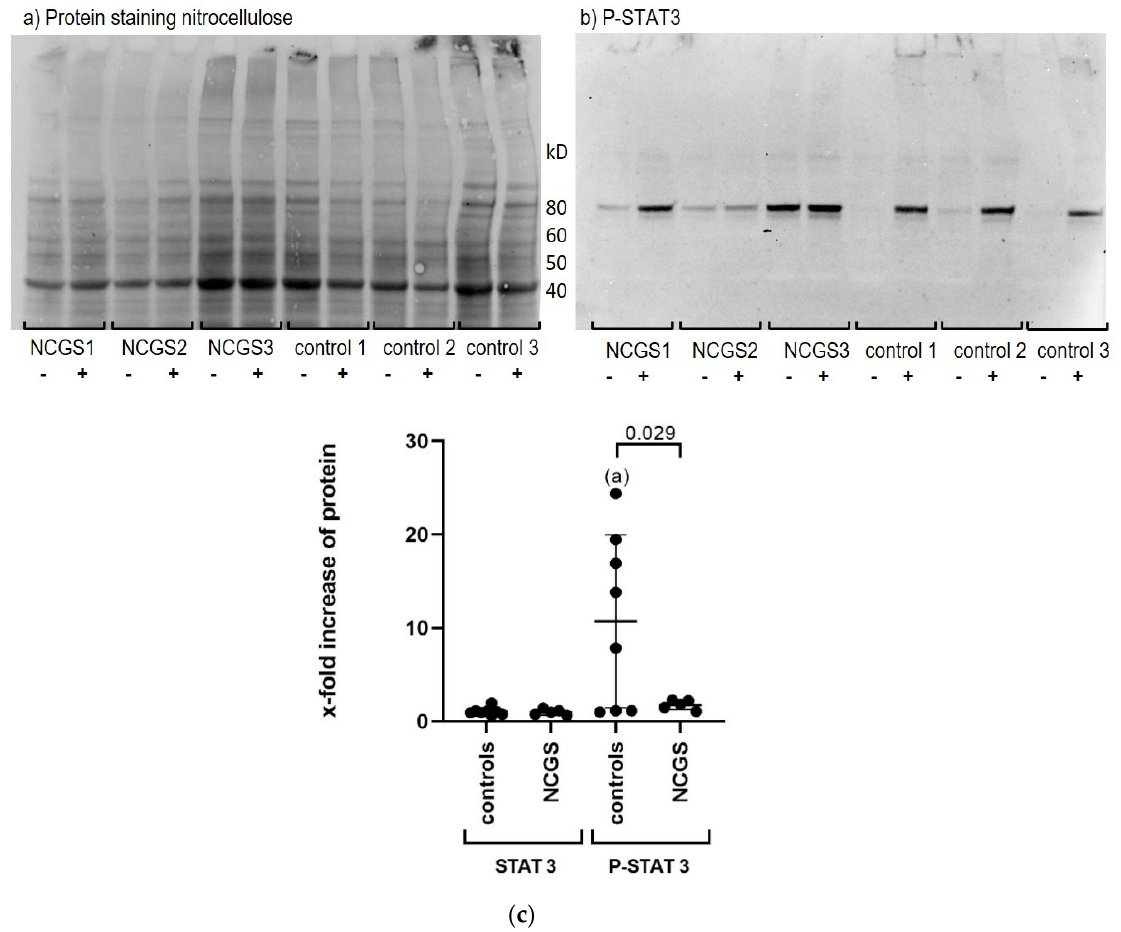
Figure 2. Gliadin-induced phopho-STAT3 protein (P-STAT3) expression in the PBMCs of healthy controls and patients with NCGS. The figure shows representative figures of ( a ) total protein staining (fluorescence) of PBMC lysates separated on 4–12% TGX Stain-Free™ protein gel after transfer to nitrocellulose, and ( b ) Western blot for P-STAT3 in the PBMC of patients with NCGS and healthy controls before and after 24 h stimulation with gliadins. Two biological replicates were performed for n = 5 out of 8 healthy controls and n = 3 out of 5 patients with NCGS, and one analysis each for the other subjects. Image Lab 6.1 (BioRad) was used to analyze the expression of P-STAT3 protein. Normalization was performed on proteins of 40 kD, i.e., ß-actin (Supplementary Figure S1). ( c ) The figure shows the x-fold enhancement of STAT3 and P-STAT3 protein in the PBMCs from healthy controls and patients with NCGS after stimulation of PBMCs with gliadins compared to a medium without cereal stimulants. Results are shown as median with interquartile range. In the healthy con- trols, the one-sample t -test revealed a significant upregulation of P-STAT3 by gliadins compared to medium control. ( a ) p = 0.021. The two-tailed t -test with Welch’s correction revealed significant dif- ferences in upregulation of P-STAT3 in PBMCs induced by gliadins between healthy controls and NCGS ( p = 0.029). p < 0.5 is considered to be statistically significant.